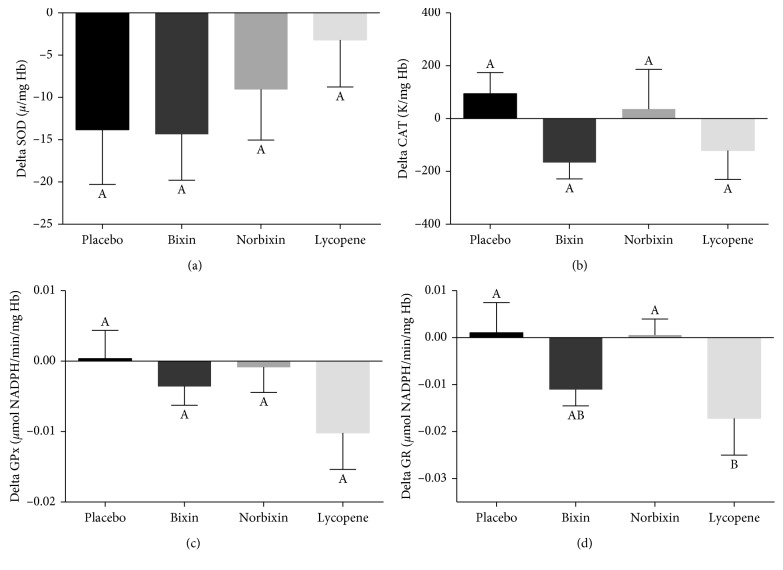
Effect of carotenoid supplementation on superoxide dismutase (a), catalase (b), glutathione peroxidase (c), and glutathione reductase (d) activities in red blood cells. Results (mean ± SEM) are presented as the delta values between final and baseline values. Different letters indicate a significant difference among treatments (p < 0.1). SOD: superoxide dismutase; CAT: catalase; GPx: glutathione peroxidase; GR: glutathione reductase.